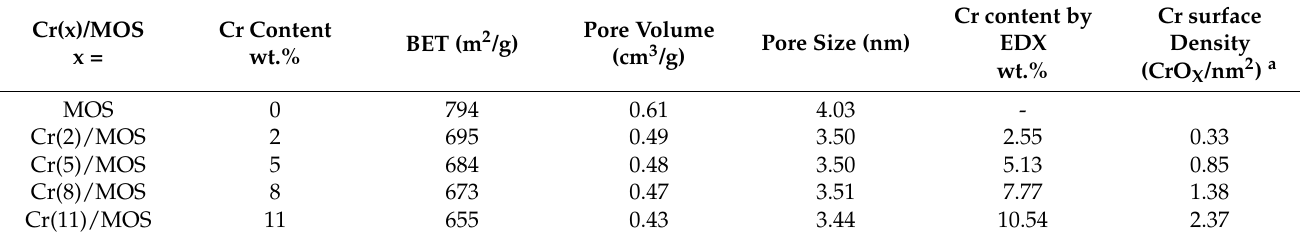
Figure 1. ( A ) N 2 sorption isotherms and ( B ) mesopore size distribution of Cr(x)/MOS catalysts prepared with varying Cr loading. Table 1. Textural properties of the MOS and Cr(x)/MOS prepared catalysts.